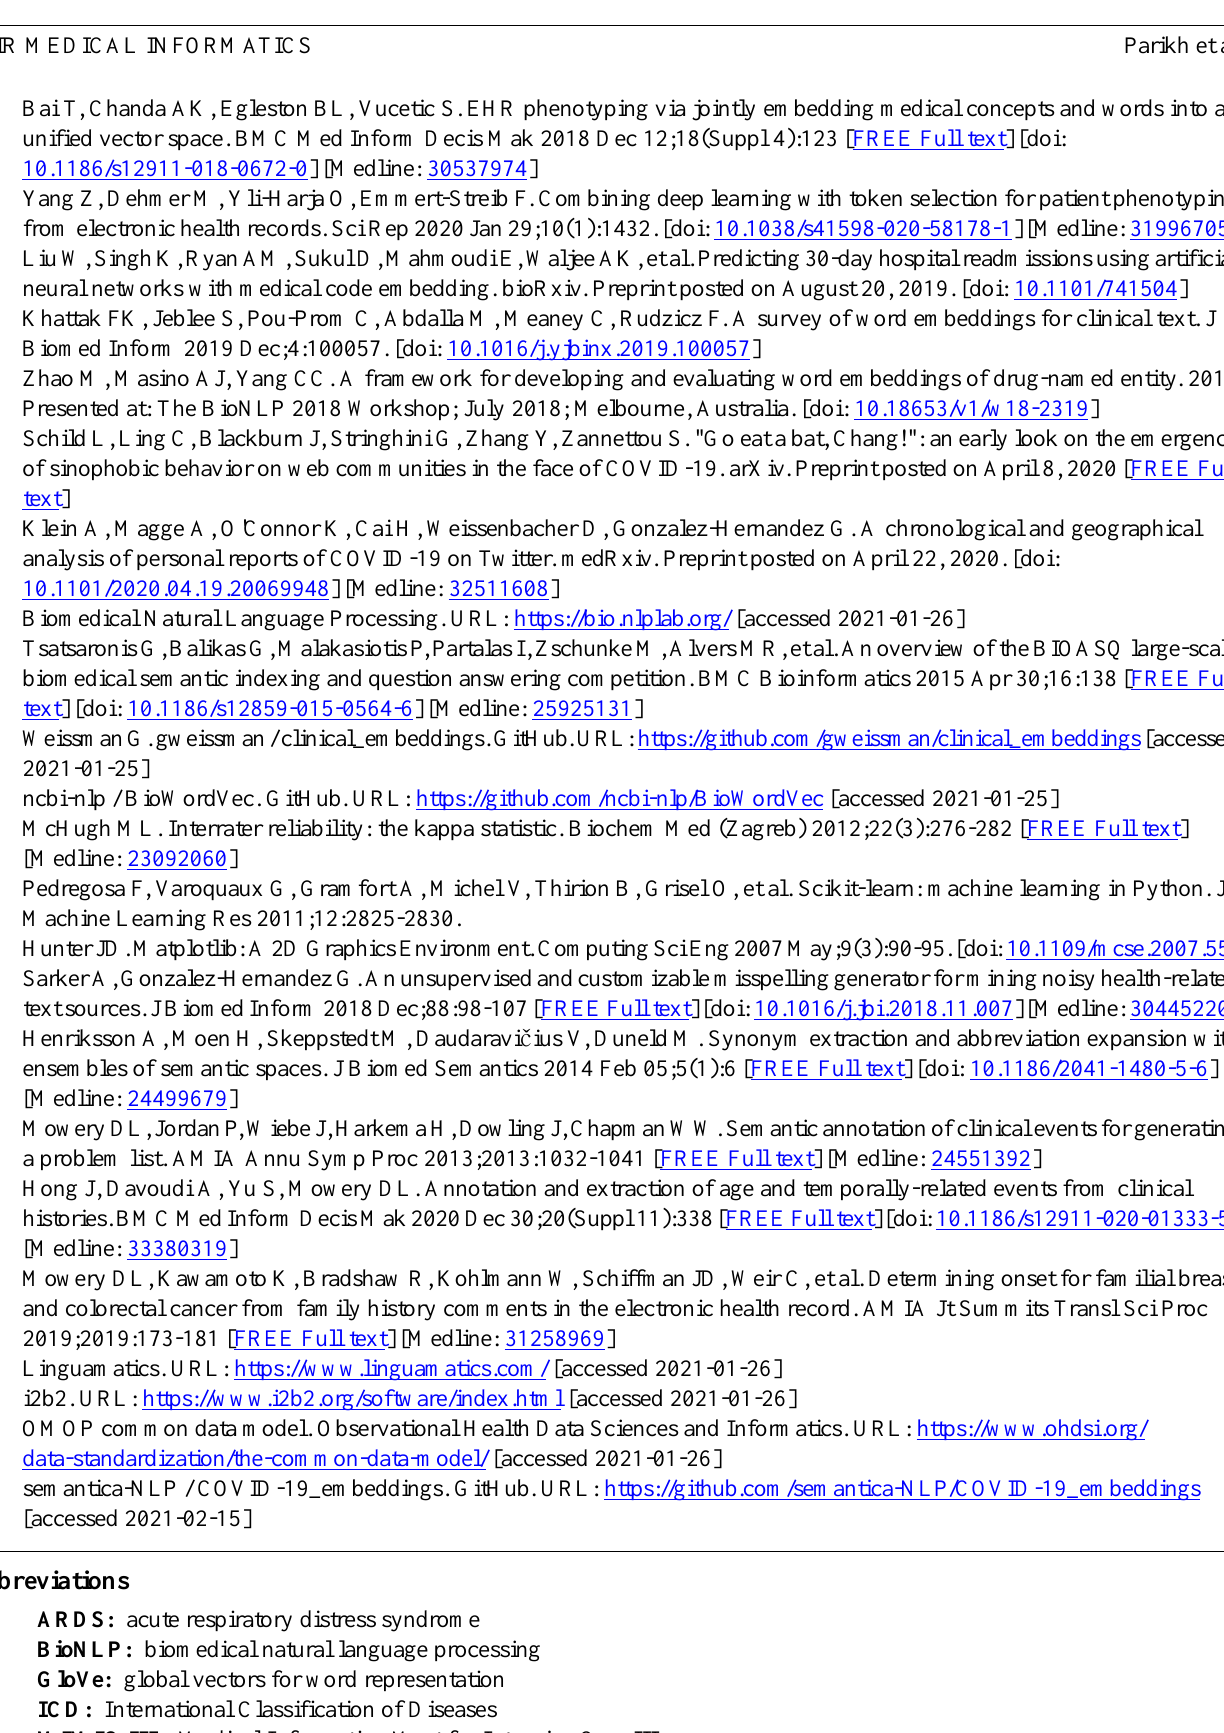
ARDS: acute respiratory distress syndrome BioNLP: biomedical natural language processing GloVe: global vectors for word representation ICD: International Classification of Diseases MIMIC III: Medical Information Mart for Intensive Care